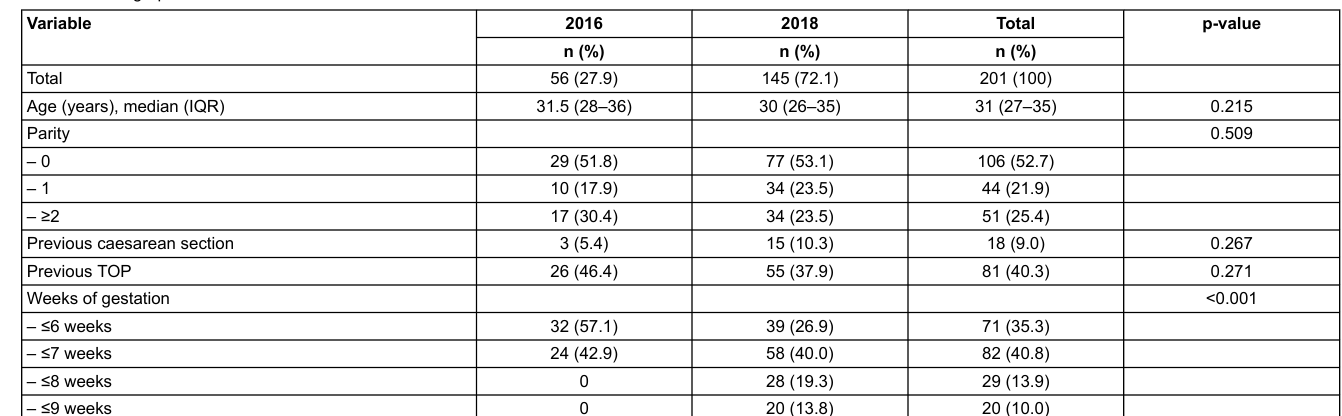
Table 2: Demographic